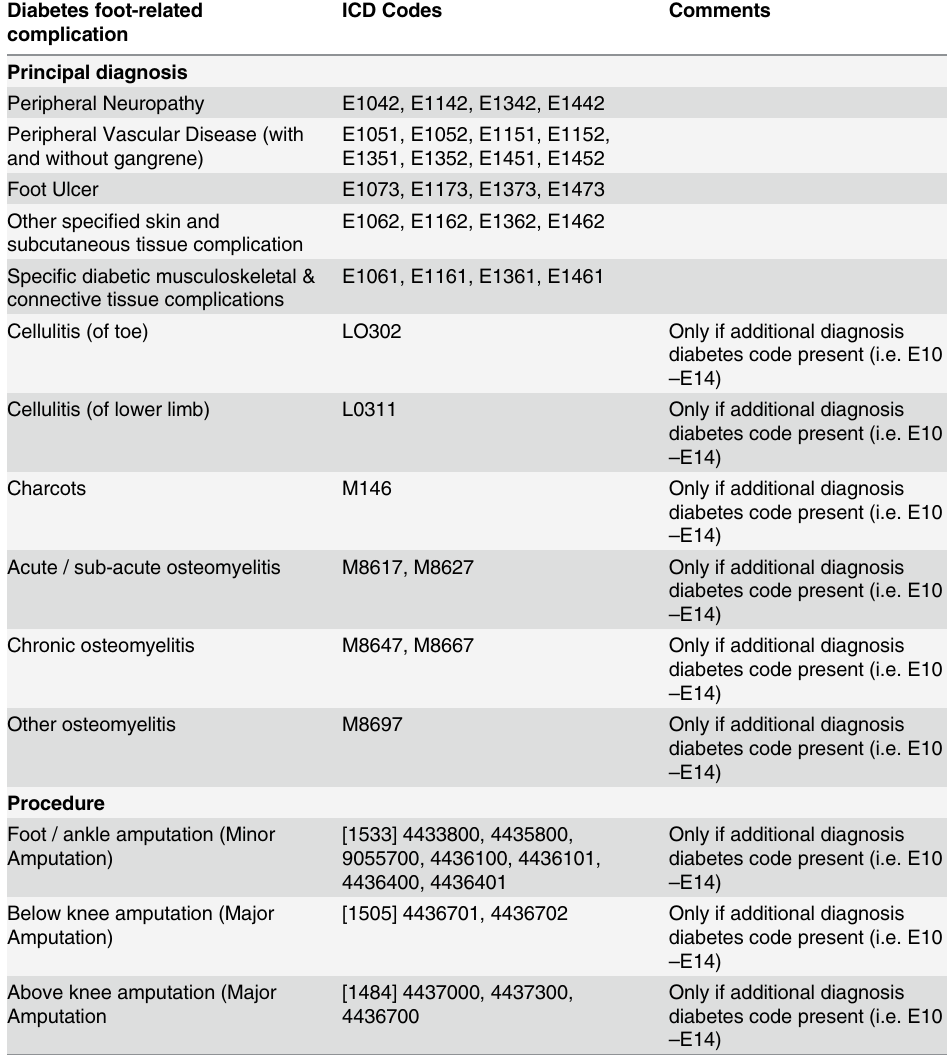
Table 1. ICD codes (ICD-10-AM) used to identify a principal diagnosis of a diabetes foot-related